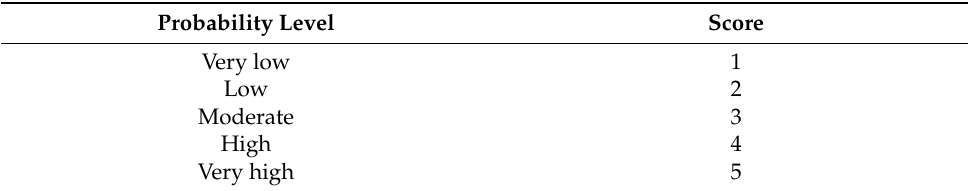
Table 3. Scoring standard table of geological hazard